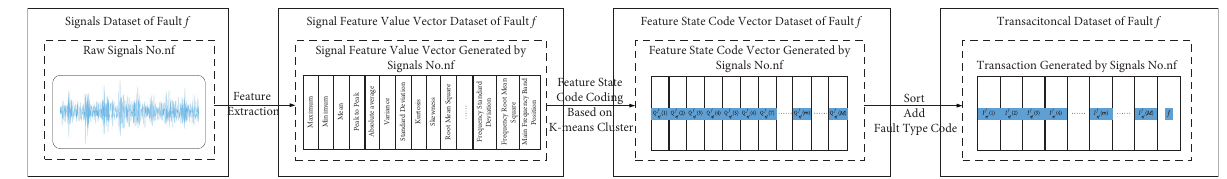
Figure 2: Process of using cluster-based feature state coding methods to complete data